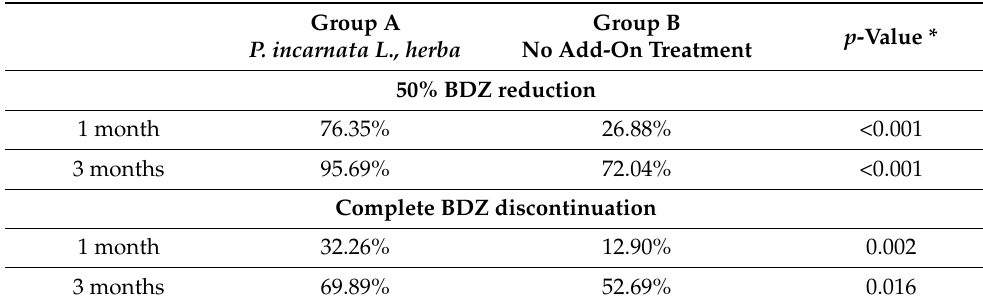
Table 2. Percentage of patients achieving 50% reduction or complete BDZ discontinuation after 1 and 3 months in the two